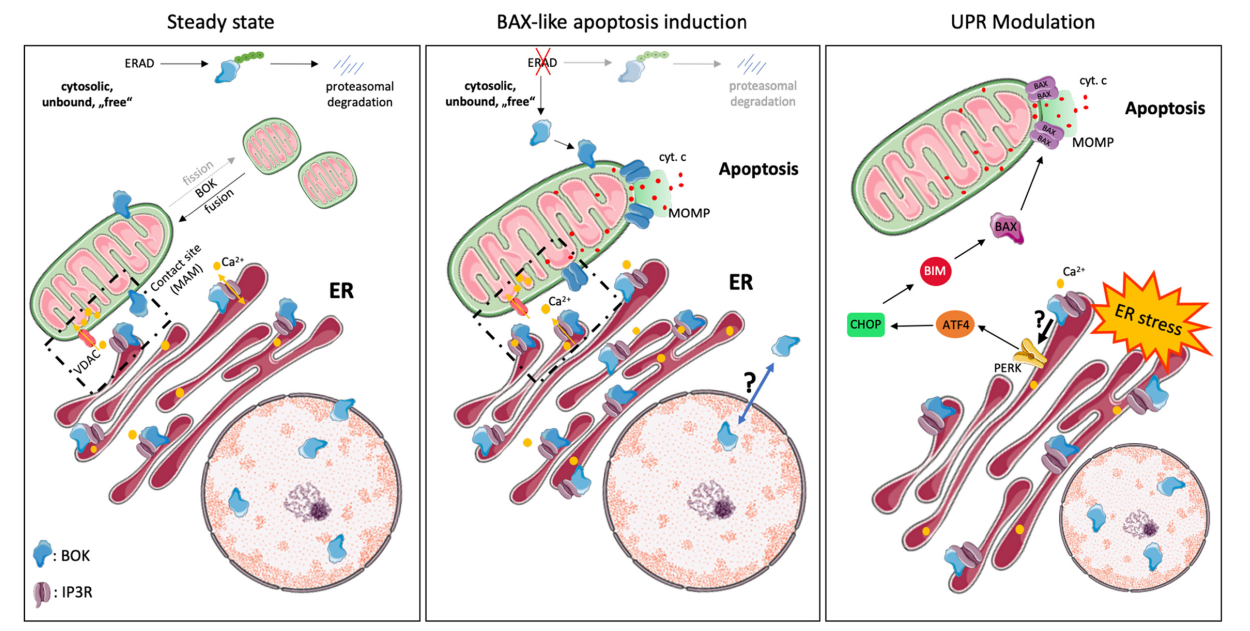
FIGURE 2 | Intracellular localization and cellular functions of BOK. BOK was described to exert various cellular functions at steady state and upon stress exposure, probably dependent on its various subcellular localizations. At steady state, the majority of BOK is bound to the ER, Golgi, and associated membranes. However, it can also be found within the nucleus, where its role is unclear, as well as on the MOM and ER-mitochondrial contact sites. ER-localized BOK is bound to IP3R and stabilizes the latter from caspase-3–mediated cleavage. IP3R-bound BOK, on the other hand, is stabilized from proteasomal turnover, as unbound, “free” BOK is ubiquitinated and degraded by the ERAD pathway. IP3R-bound BOK may thus not be available for mitochondrial apoptosis induction. No direct effect of BOK in altering Ca 2 + mobilization by IP3Rs has been observed so far. Recently, BOK was found to be important for mitochondrial fission and morphology and thus to affect mitochondrial membrane potential. BOK has furthermore been described to exert a BAX-like killing function. Disturbance of components of the ERAD pathway thereby results in the stabilization of “free” BOK protein, which then directly induces MOMP and apoptosis in a BAX-like manner, independently of other BCL-2 family members. Under certain stress conditions, e.g., under hypoxia, BOK is upregulated and translocates from the nucleus into the cytoplasm and to mitochondrial membranes by a still unknown mechanism, where it may induce apoptosis. Increasing evidence points toward a UPR-modulating function by BOK, following ER stress, by a yet unknown mechanism. In that respect, BOK was described to regulate the PERK > ATF4 arm along with CHOP, which induces the BH3-only protein BIM (and PUMA). BIM directly activates BAX/BAK, leading to MOMP and subsequent apoptosis, suggesting an apoptosis-inducing role of BOK upstream of MOMP in that